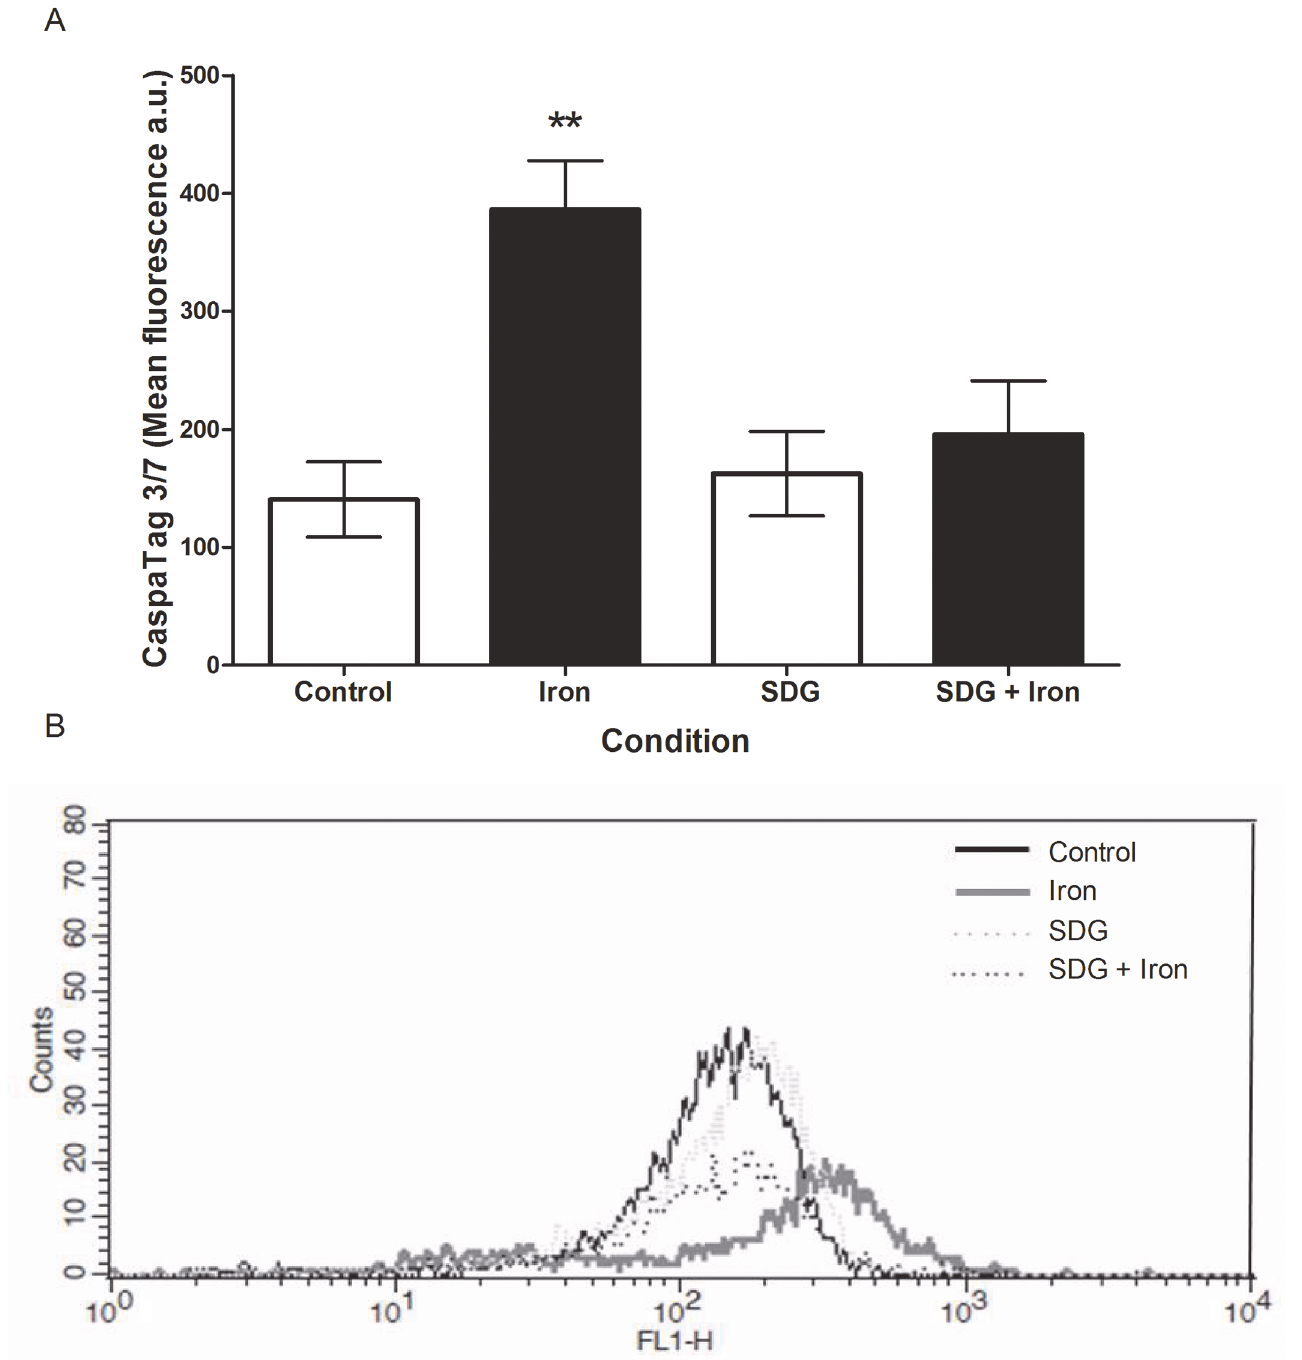
Fig 6. SDG decreases iron-induced caspase 3/7 activity in H9c2 cells. Active caspases 3/7 in control, 50 μ M iron-treated, 500 μ M secoisolariciresinol diglucoside (SDG), and SDG pre-treatment + iron-treated H9c2 cells. Caspase levels were determined via the CaspaTag 3/7 assay and measured via flow cytometry. Data is expressed as mean fluorescence arbitrary units (a.u.) (A). The representative histogram of cell count versus FL1 fluorescence (B). ( ** = p < 0.01 versus control, n = 3).